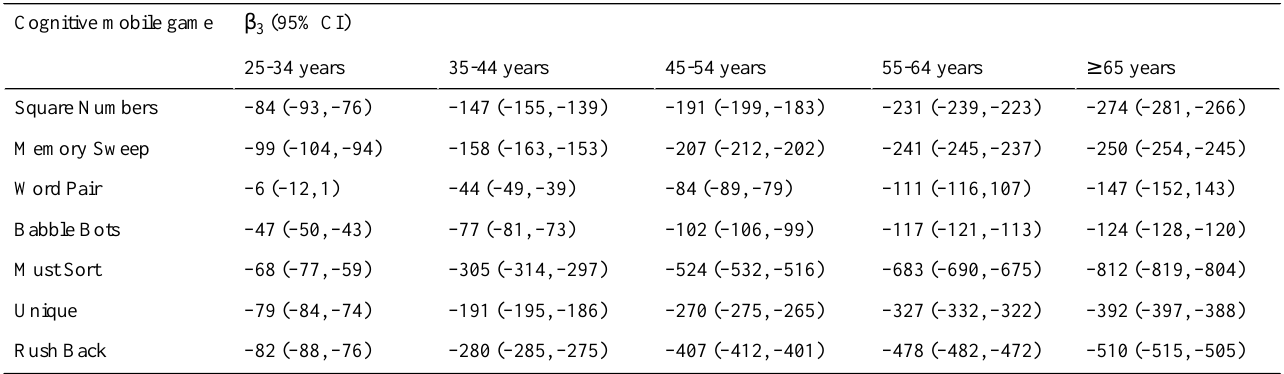
Table 2. Results of the mixed effect model analysis for the interaction between session and age group for each cognitive mobile game.